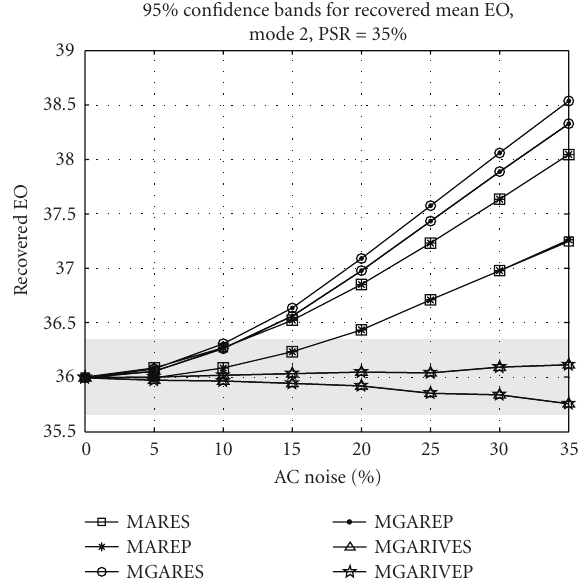
Figure 7: Test 1: 95% confidence bands for exact solution methods, mode 2.